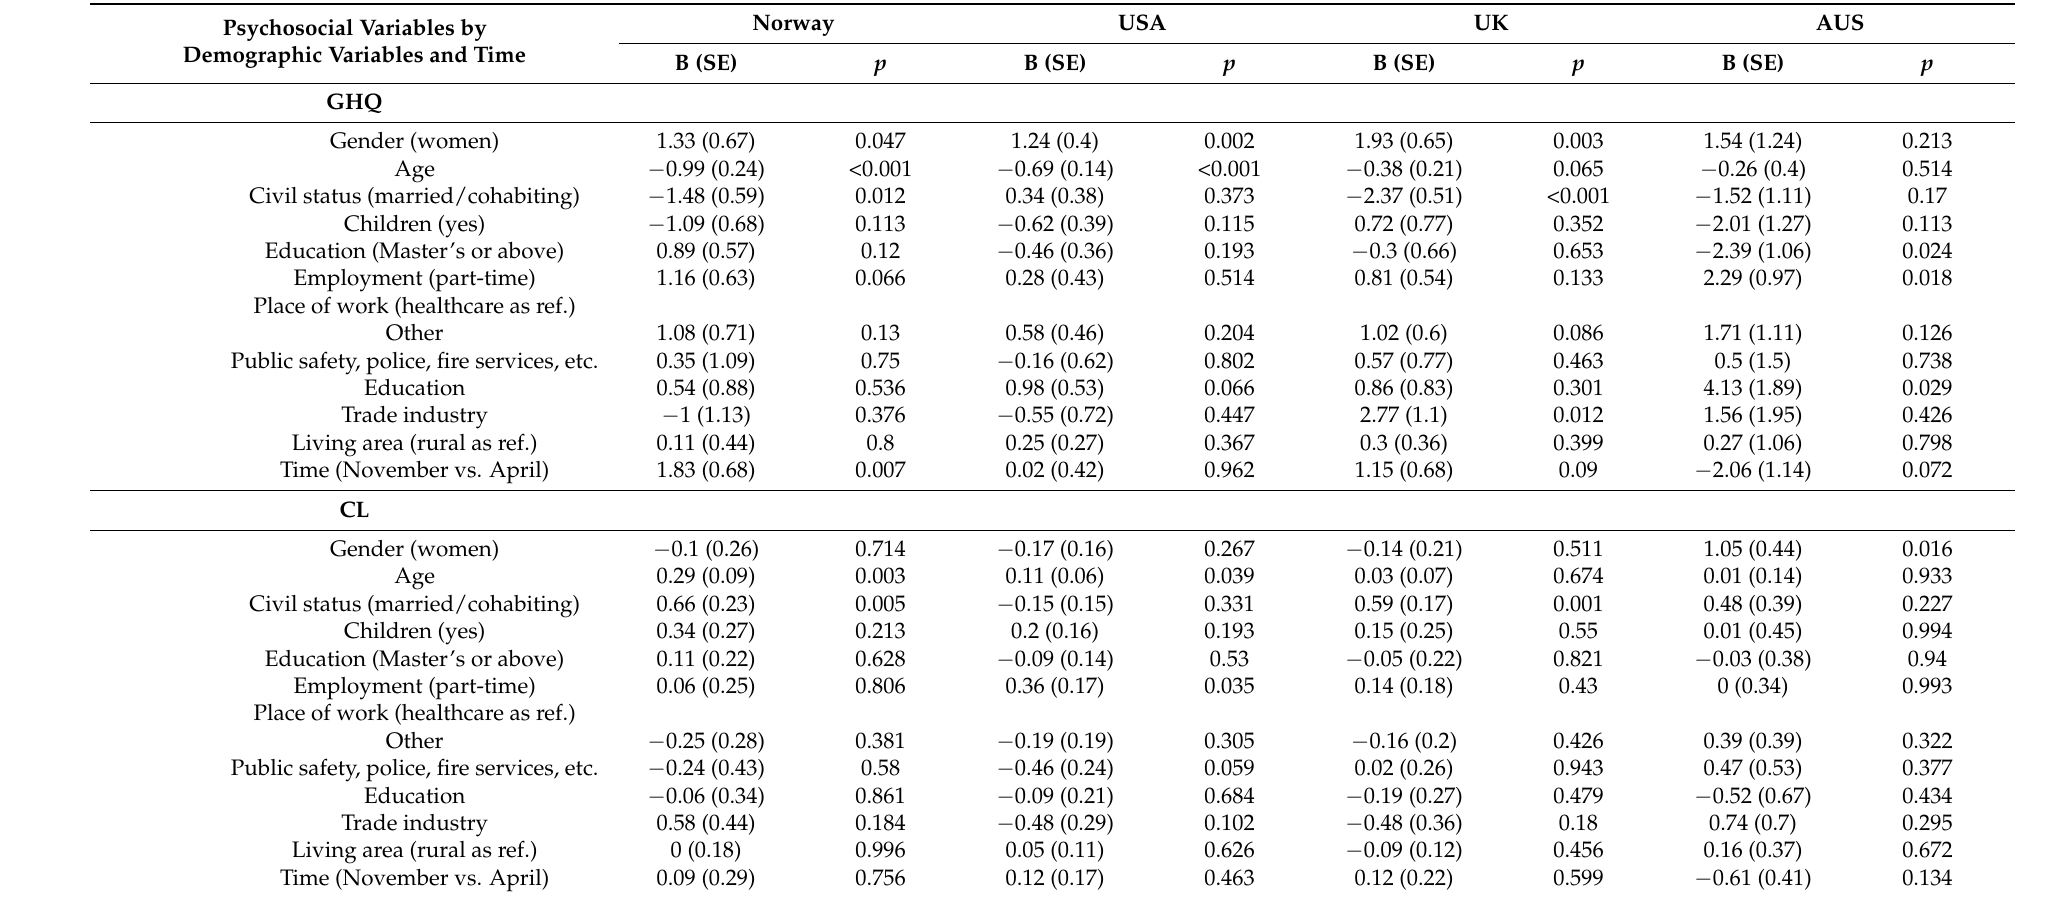
Table 4. Multiple linear regression analysis in each